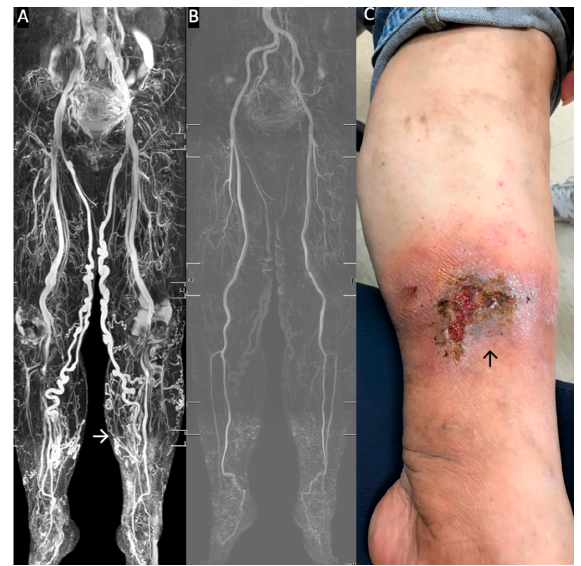
Figure 2. Standard Triggered angiography non-contrast-enhanced (TRANCE)-magnetic resonance imaging (MRI) evaluation for patients with stasis leg ulcers. ( A ) Full TRANCE-MRI. The TRANCE-MR image of the venous system clearly shows the tortious great saphenous vein (GSV) in both legs. The white arrow indicates the stasis leg ulcer. ( B ) The TRANCE-MRI can also identify the arterial system. There is no need for radiation or injection of contrast medium. ( C ) Stasis leg ulcer of the gaiter area. This wound healed one month later, after truncal ablation of the left